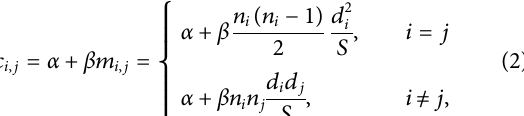
Frontiers in Big Data |